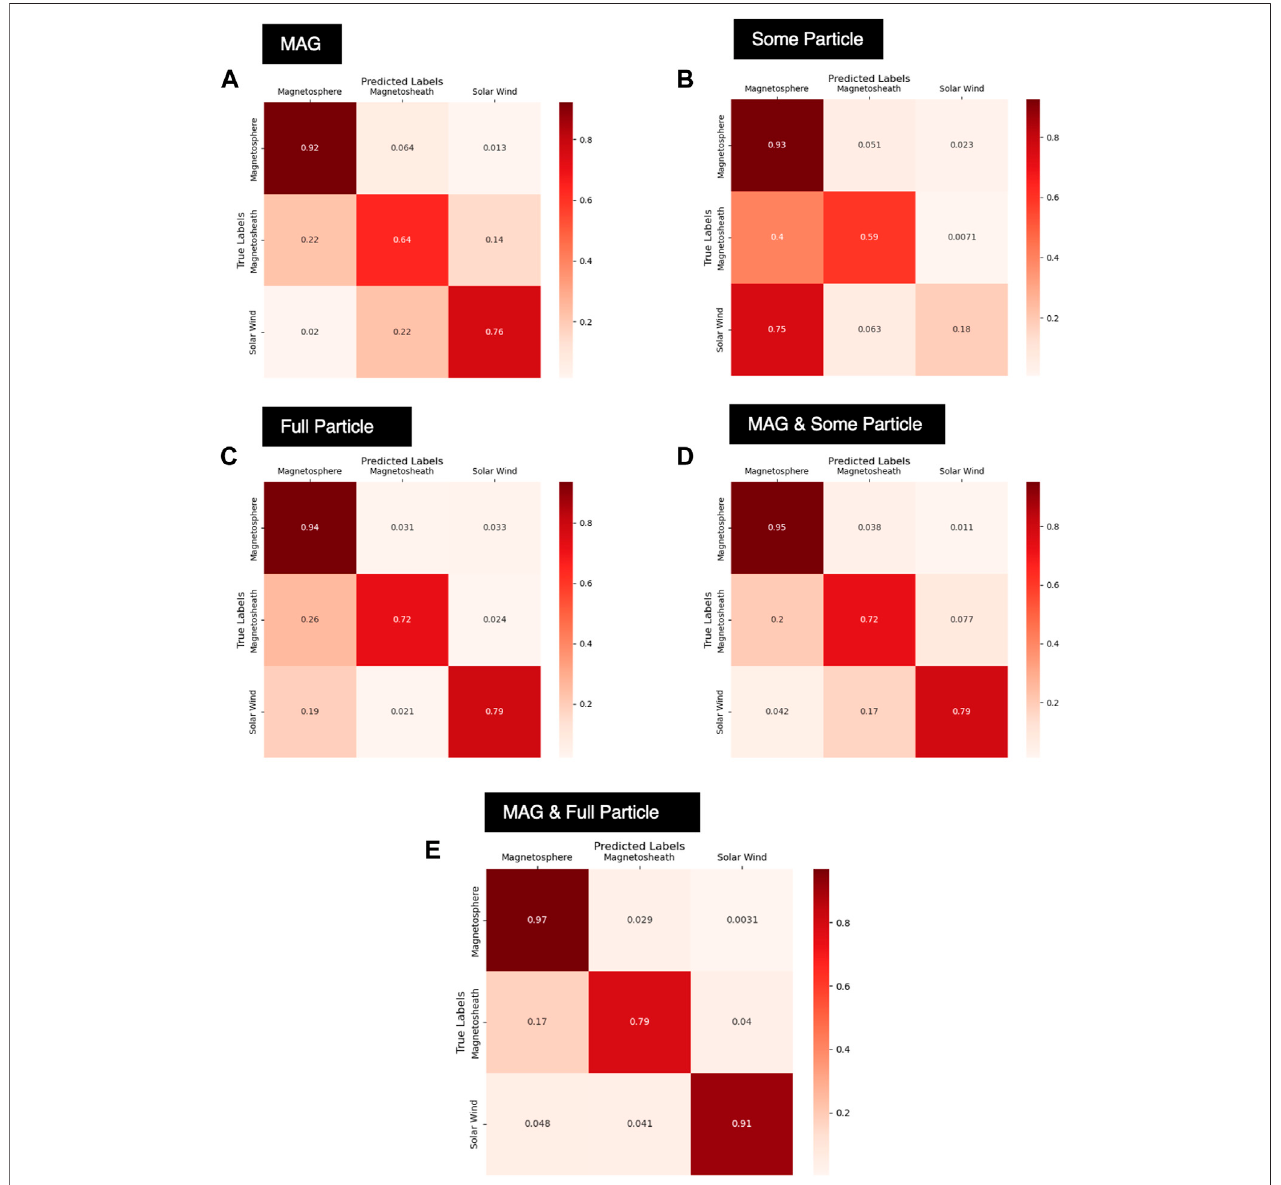
FIGURE 5 | Normalized confusion matrices for different combinations of data, all using the RF model which was the best performing model across all feature sets [ (A) MAG-only, (B) Some particle, (C) Full particle, (D) MAG & some particle, and (E) MAG & full particle]. The comparisons here are shown as normalized confusion matricesinwhicheach rowisdividedbythenumberof “ true ” samplesintheclass.Aperfect modelwould haveallonesonthediagonal andall zerosontheoff-diagonal.